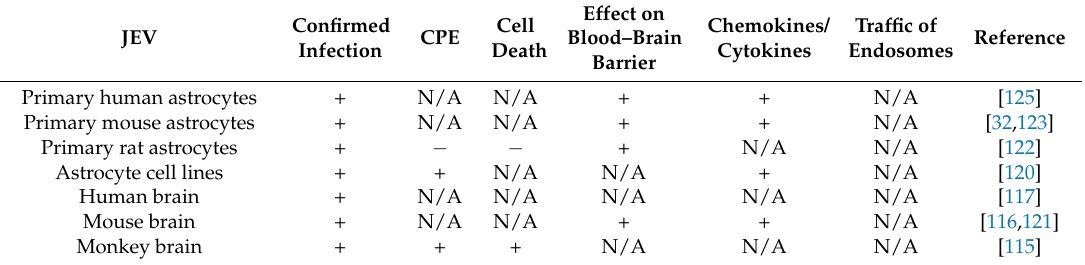
Table 4. Effects of Japanese encephalitis virus (JEV) infection on astrocytes and whole